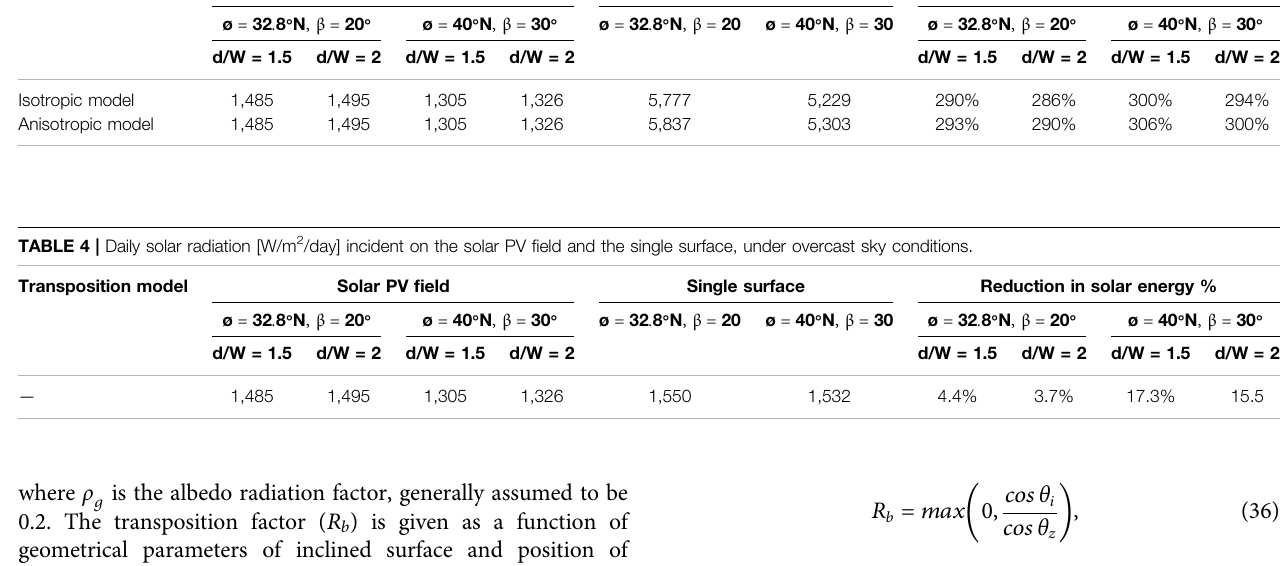
Isotropic model